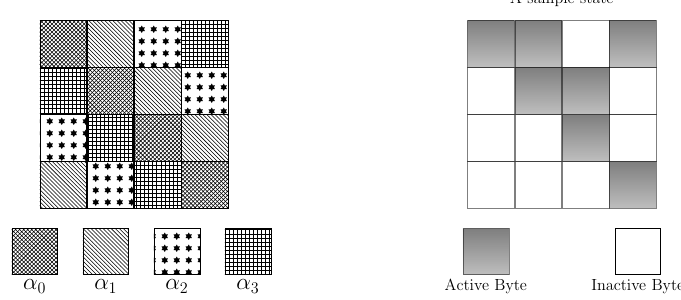
Figure 2: Different words and a sample state showing zero and non-zero